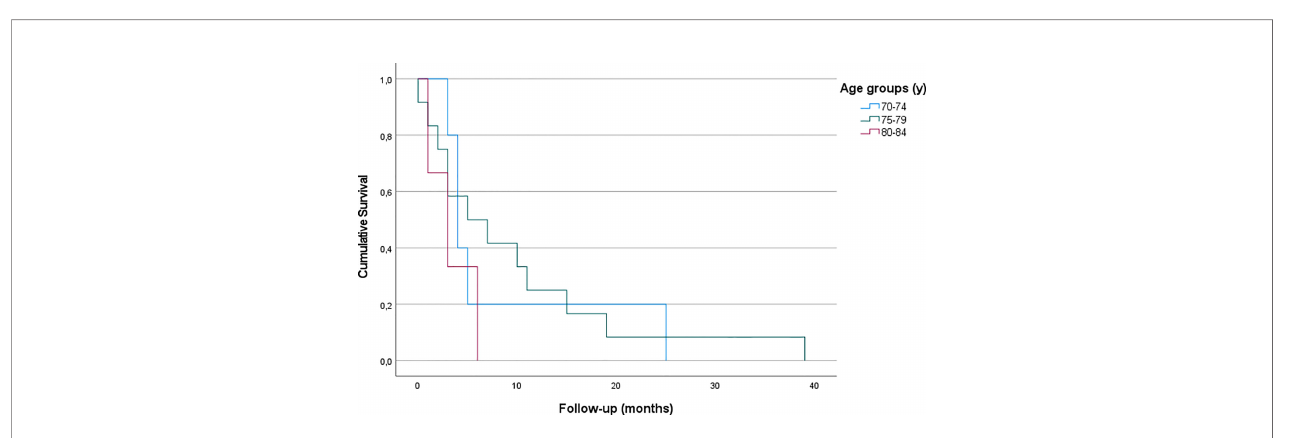
FIGURE 3 | Kaplan-Meier curves for patients of all age groups who received GTR (p -